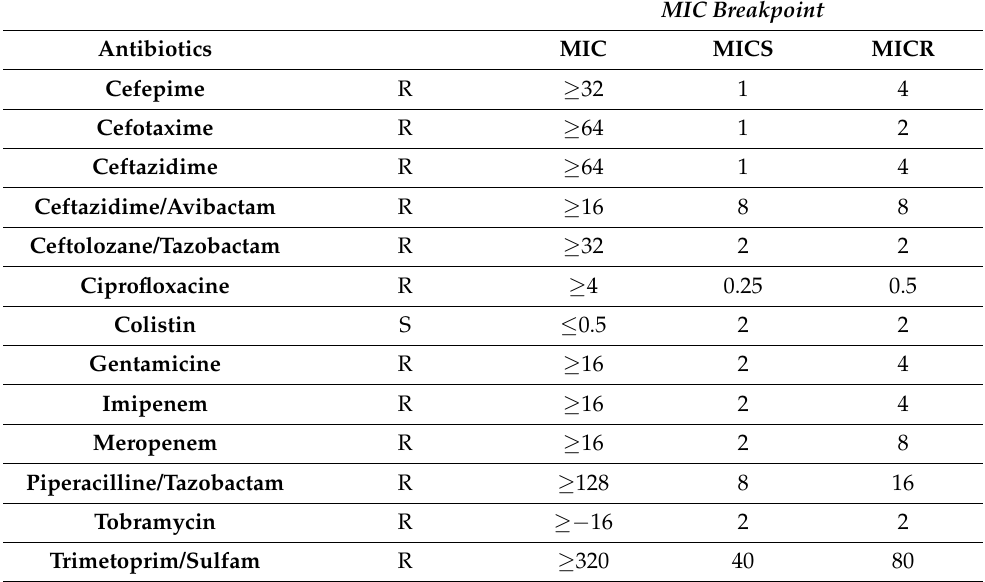
Table 1. Resistance profile of the K. pneumoniae NDM strain found in the blood